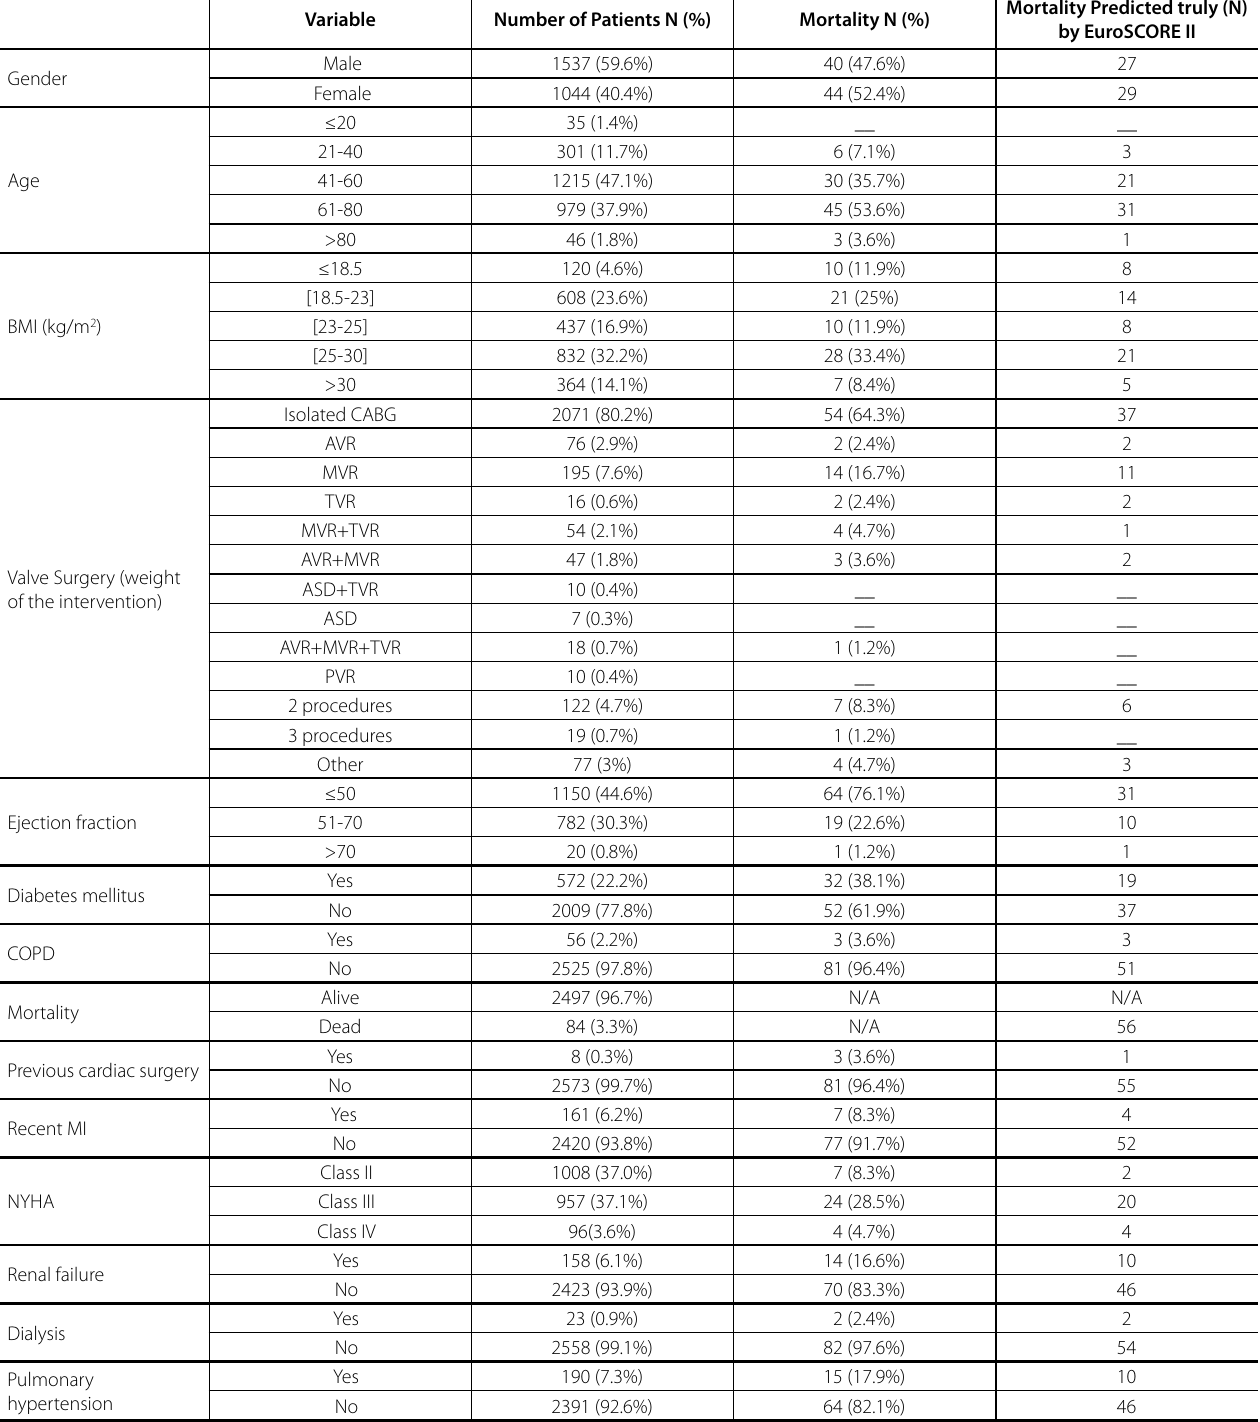
Table 2. EuroSCORE II characteristics by patients’ demographic and clinical characteristics; number of patients and relation with mortality. The expected and observed mortality can also be compared by any variable [2]